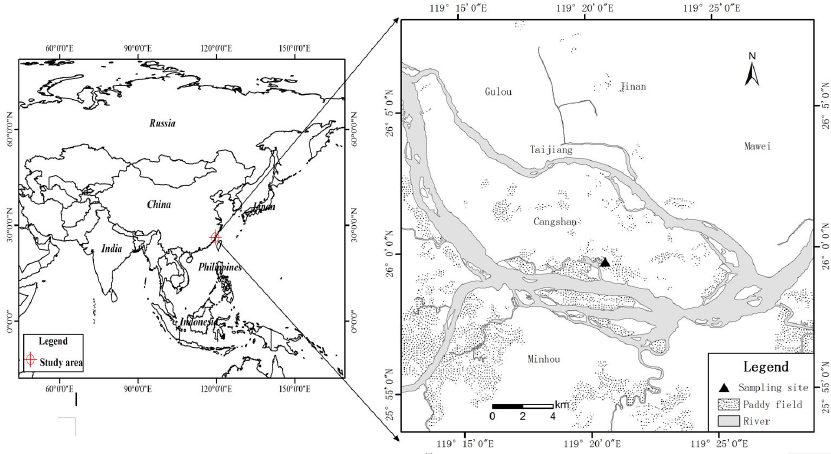
Figure 1. The location of the study area and sampling site ( (cid:78) ) in southeast